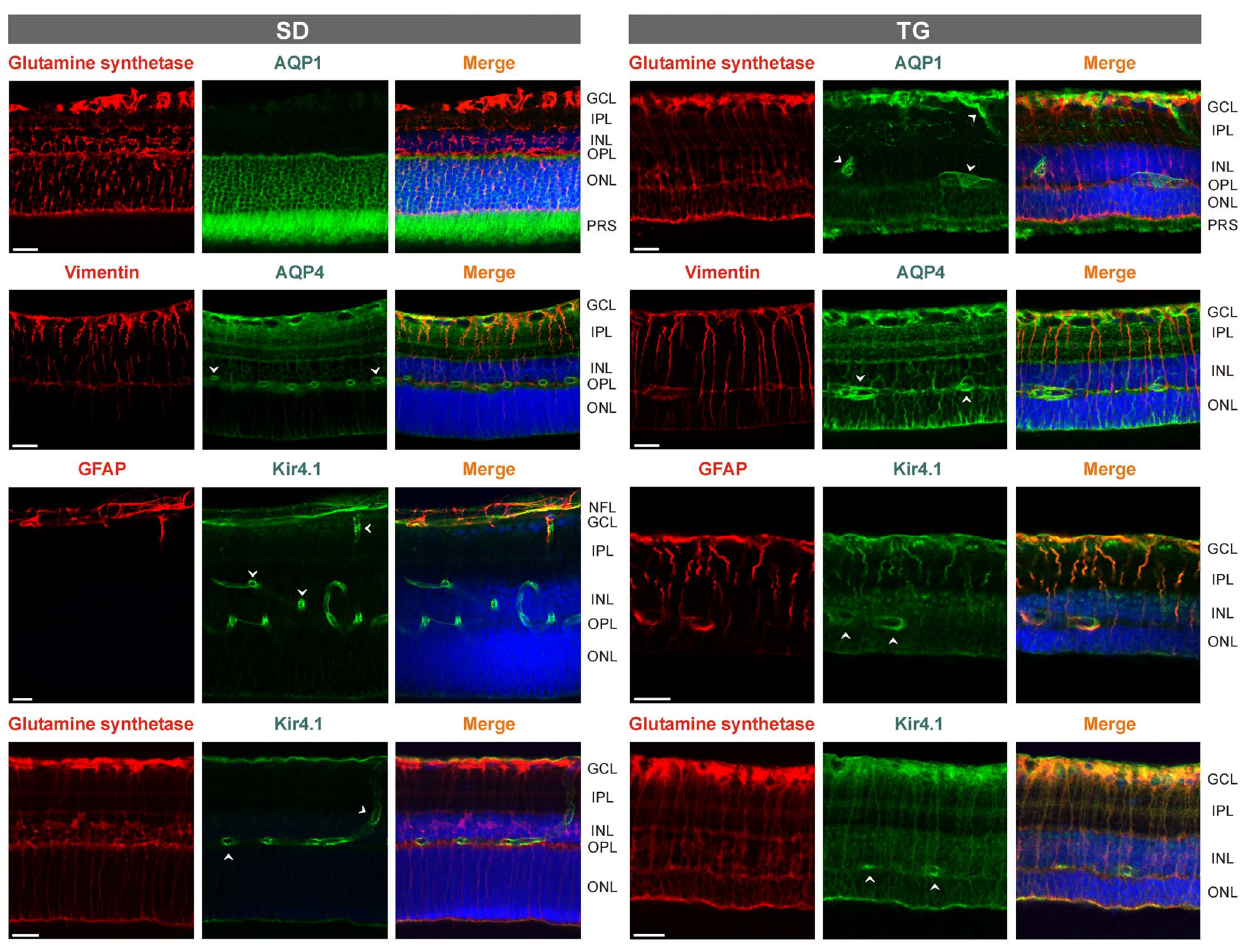
Figure 1. Immunolocalization of Kir4.1, AQP1, AQP4, GFAP, vimentin, and glutamine synthetase in retinal slices. The slices were obtained from 3-months control (SD; left side ) and transgenic (TG) rats ( right side ). Co-labeling of two proteins yielded a yellow-orange merge signal. Cell nuclei were stained with Hoechst 33258 ( blue ). Arrowheads , perivascular labeling. Note the thinning of the retinal tissues from TG rats in comparison to the tissues of SD rats. GCL, ganglion cell layer; IPL, inner plexiform layer; INL, inner nuclear layer; NFL, nerve fiber layer; ONL, outer nuclear layer; OPL, outer plexiform layer; PRS, photoreceptor segments. Bars, 20 m m.